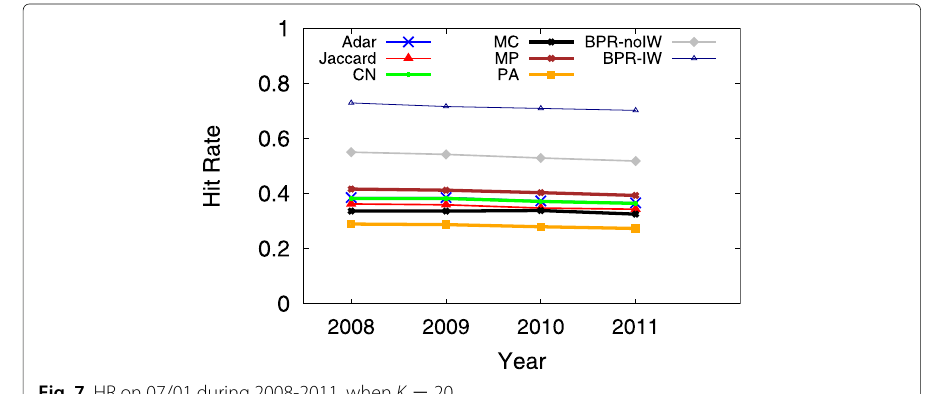
Fig. 7 HR on 07/01 during 2008-2011, when K = 20